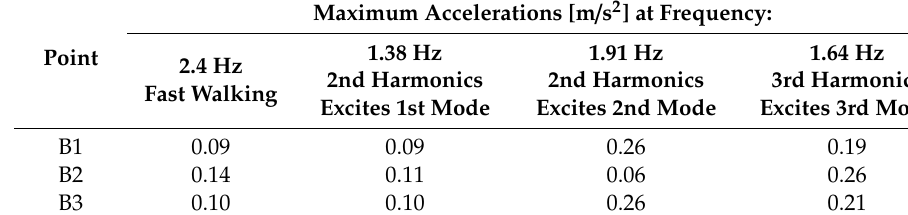
Table 12. Maximum vertical accelerations generated by a single pedestrian walking obtained at the representative points of the beam footbridge with the GFRP slab for the selected frequencies.